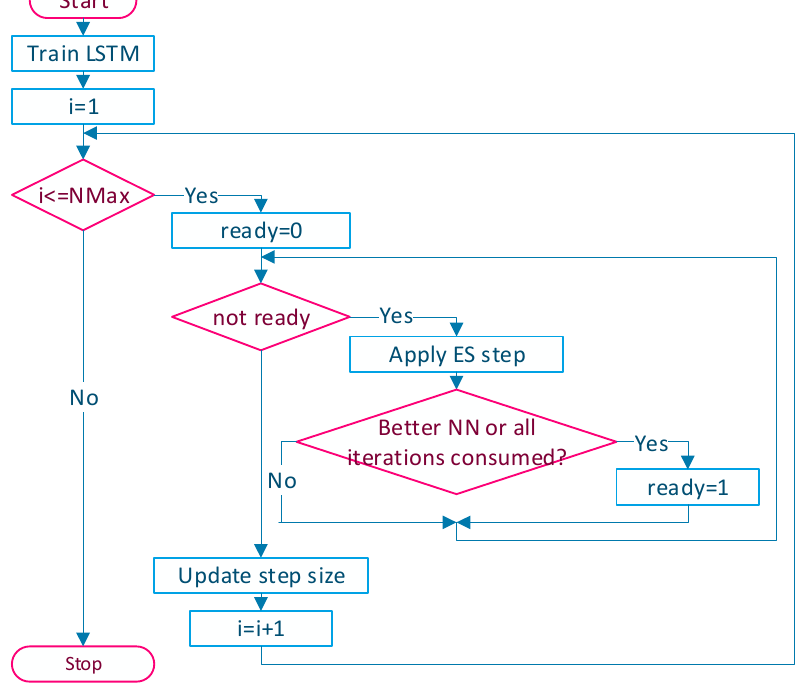
Figure 3. Brief description of the proposed algorithm.